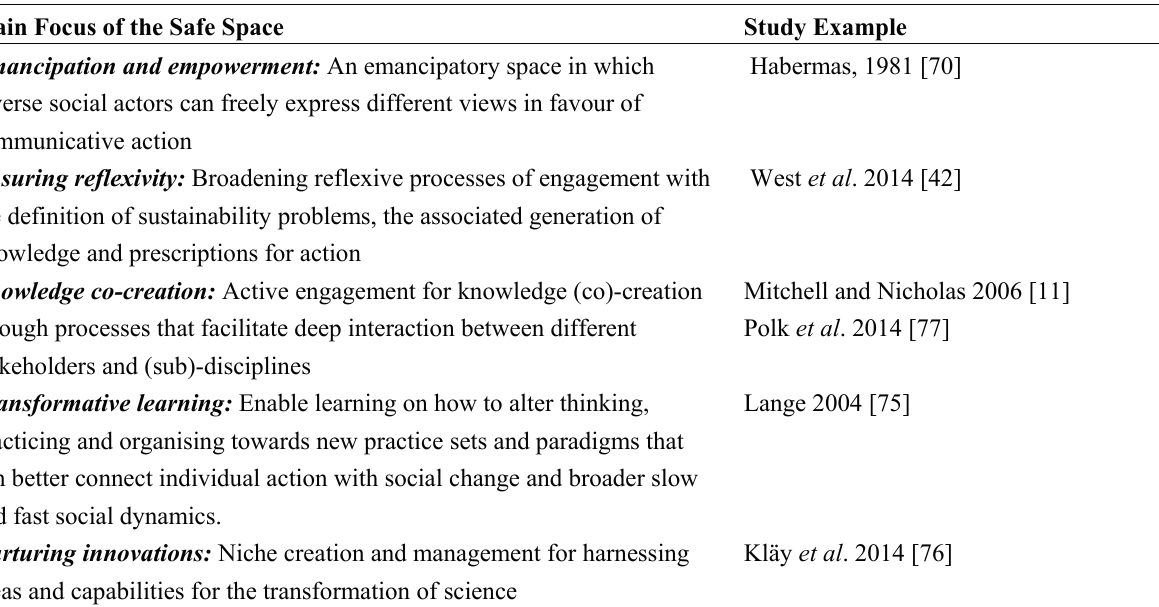
Table 2. Principles of the ‘safe space’ advocated in this